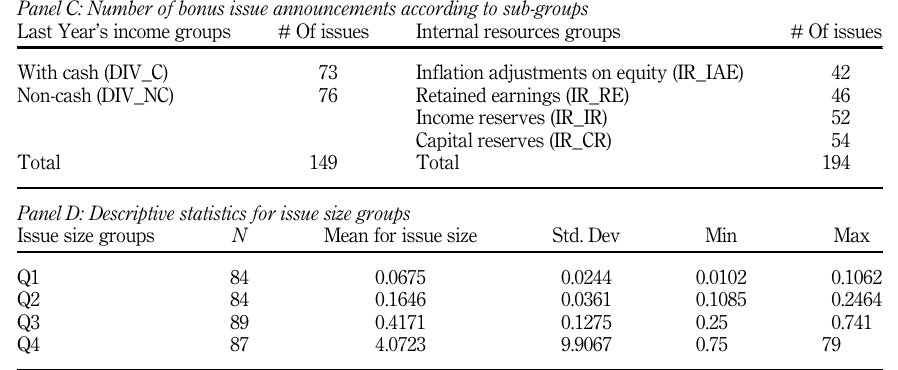
Panel C: Number of bonus issue announcements according to sub-groups Last Year ’ s income groups